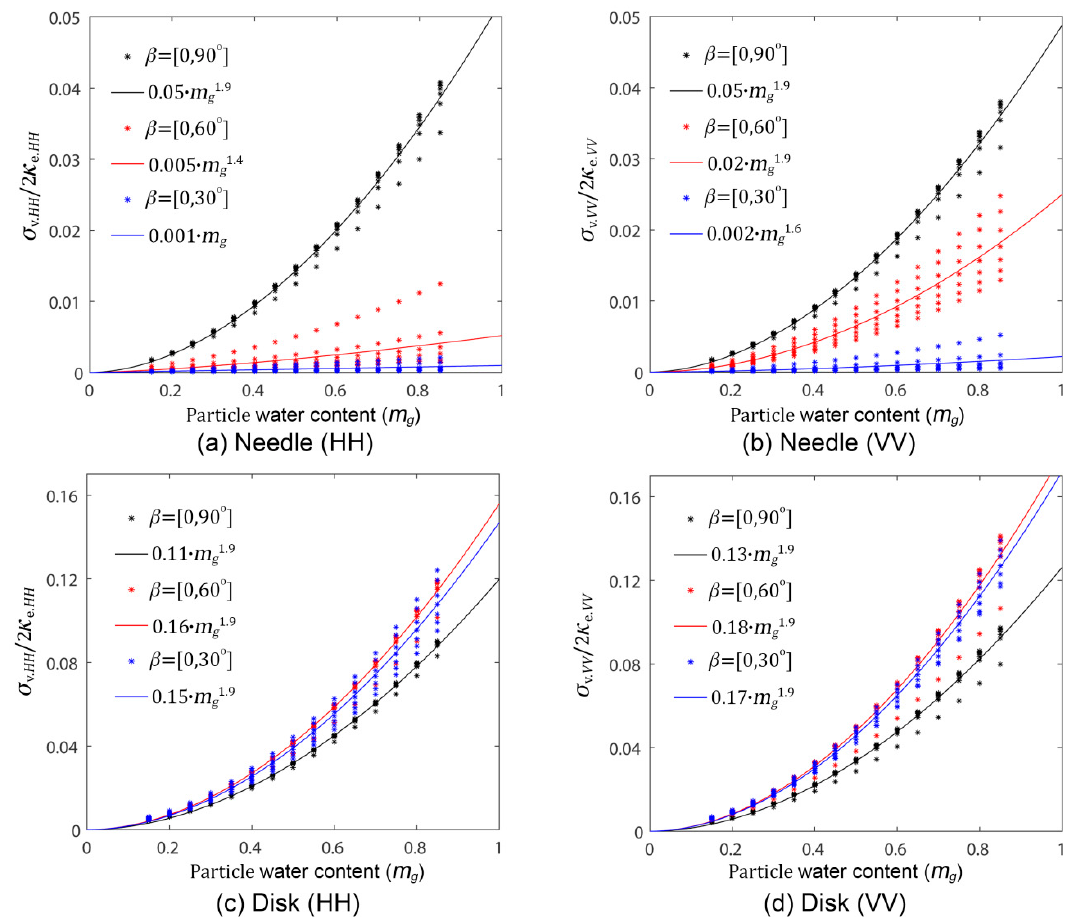
Figure 7. E ff ect of particle orientation distribution on the relationship between σ v , pq /2 κ e , pq and A 2, pq m g Figure 7. Effect of particle orientation distribution on the relationship between 𝜎 (cid:3049),(cid:3043)(cid:3044) /2𝜅 (cid:3032),(cid:3043)(cid:3044) and (left: A 2, HH m g and right: A 2, pVV m g ) in the case of ( a , b ) needle shaped and ( c , d ) disk shaped 𝐴 (cid:2870),(cid:3043)(cid:3044) 𝑚 (cid:3034) (left: 𝐴 (cid:2870),(cid:3009)(cid:3009) 𝑚 (cid:3034) and right: 𝐴 (cid:2870),(cid:3043)(cid:3023)(cid:3023) 𝑚 (cid:3034) ) in the case of ( a ),( b ) needle shaped and ( c ),( d ) disk shaped particles.